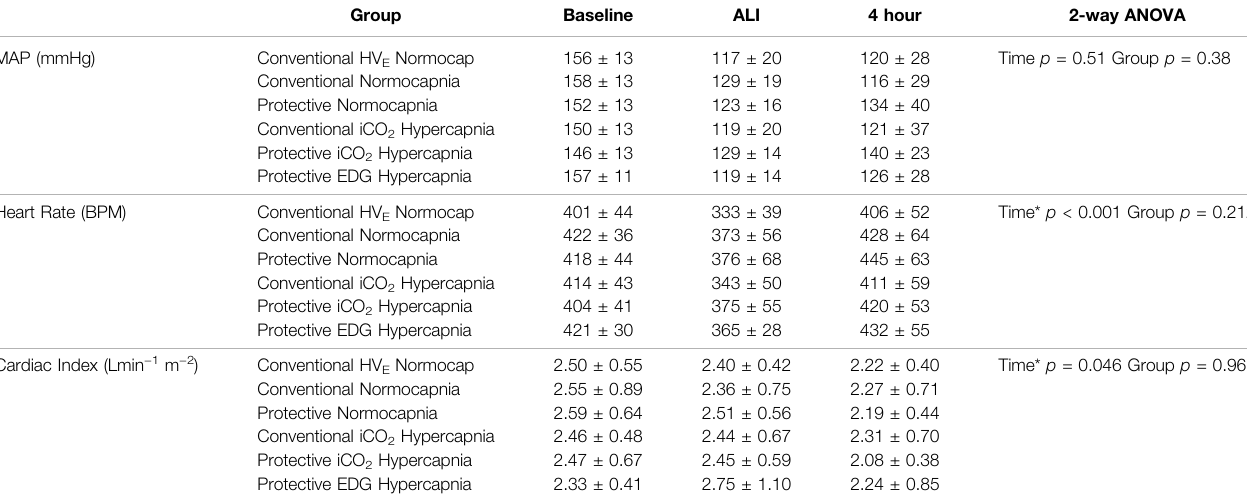
TABLE 2 | Hemodynamic measurements at baseline, ALI and after 4 h of ventilation in each group, including mean arterial pressure (MAP), heart rate (beats per minute, BPM), and cardiac index. Values are expressed as mean ± SD. Baseline data given for reference only, but not included into statistical analysis. There were no signi fi cant differences between groups. * denotes signi fi cance between ALI and 4 h measurements with no signi fi cant interaction between groups.